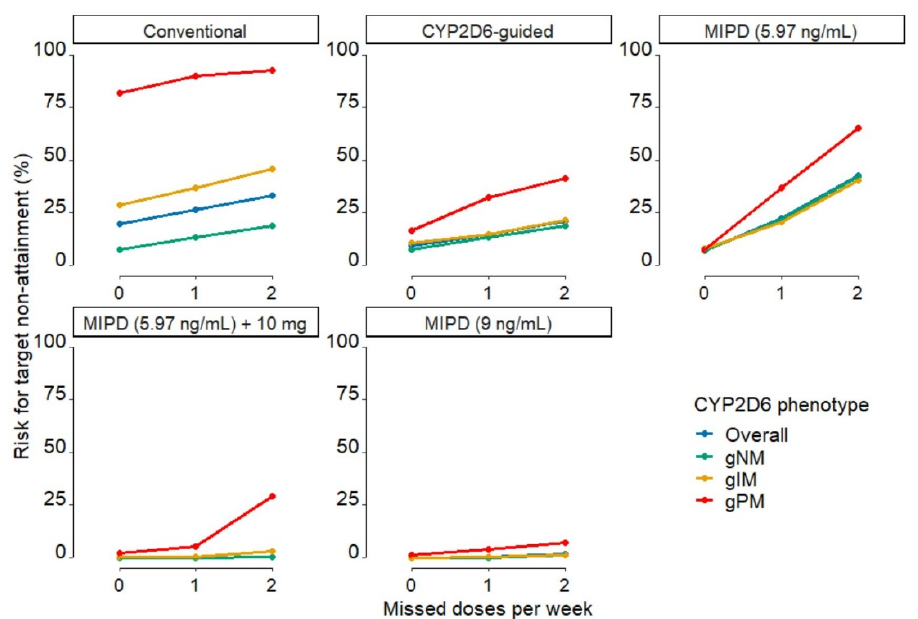
Figure 3. Risks for non-attainment of target minimum endoxifen concentrations at steady-state (C SS,min ENDX ) in the different dosing regimens in fully adherent patients, patients missing one dose per week and patients missing two consecutive doses per week for six months. Green: gNM, yellow: gIM, red: gPM, blue: overall. Abbreviations: MIPD: model-informed precision dosing; gNM, gIM, and gPM: genotype-predicted normal, intermediate, and poor metabolisers, respectively.